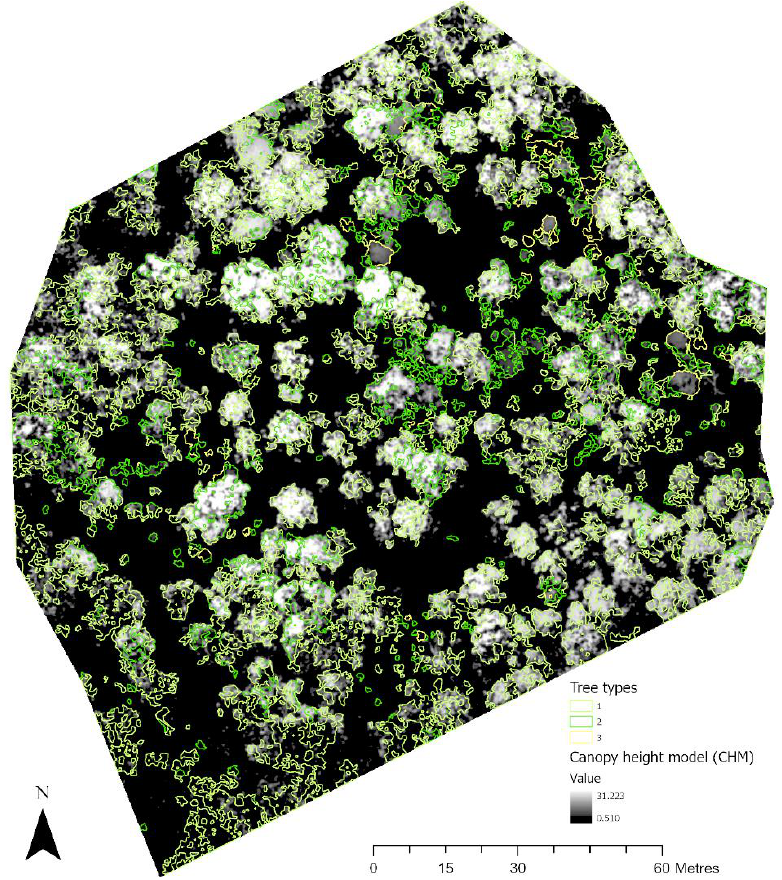
Figure 7. Generation of canopy height model allowing extraction of height information for different trees.